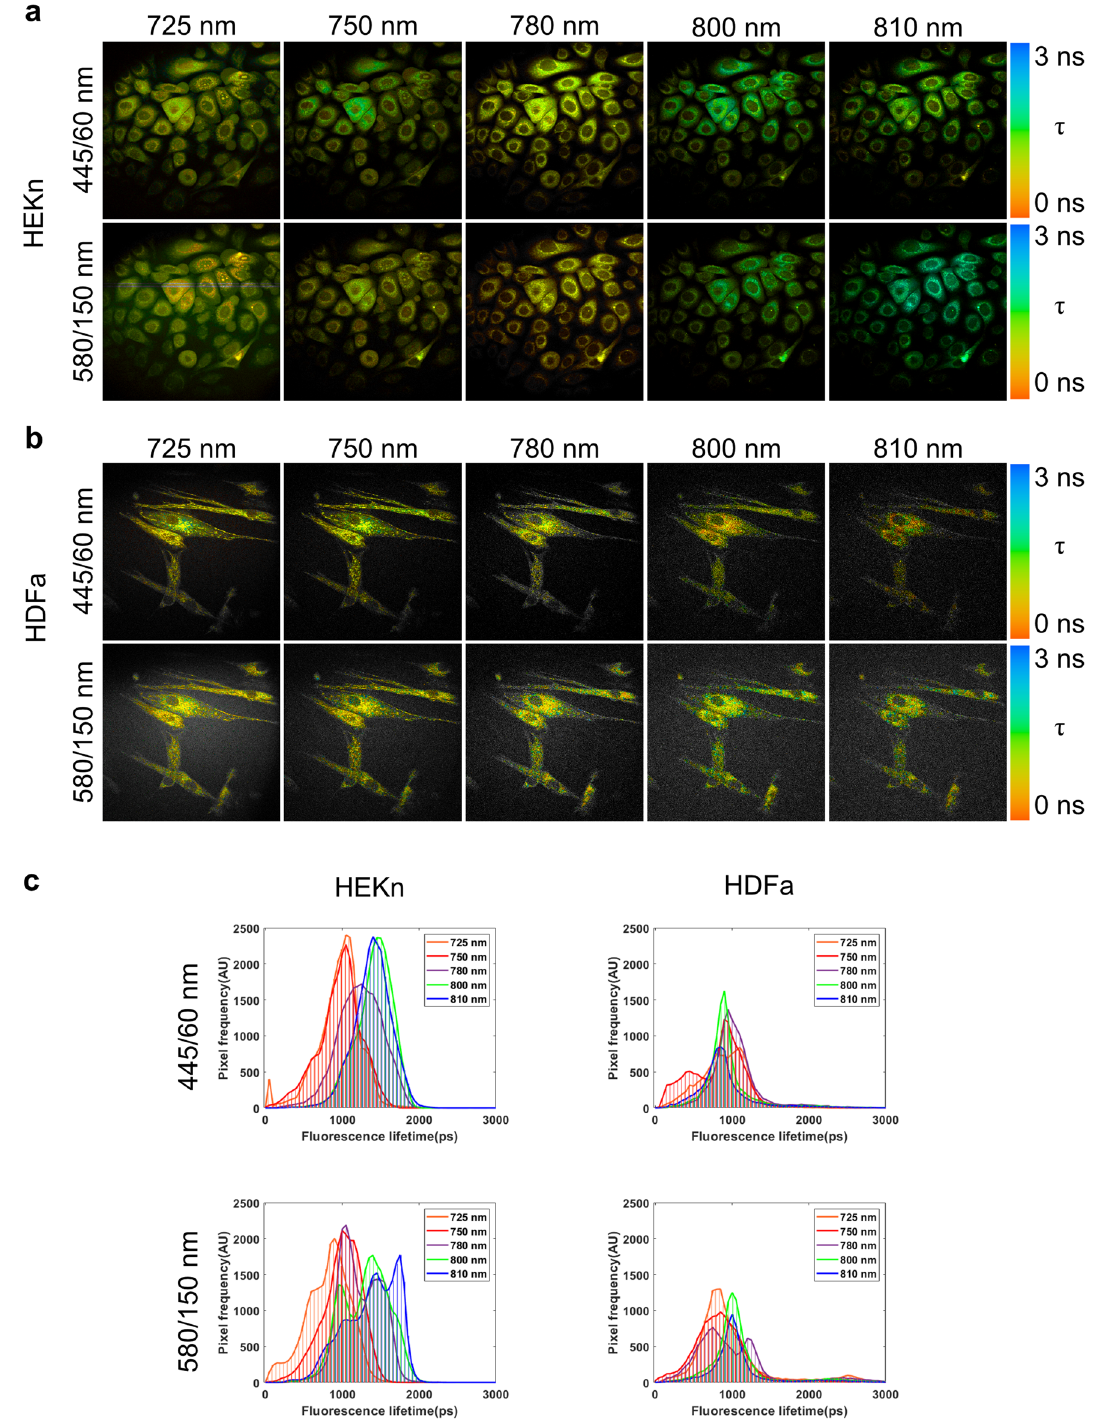
Figure 4. MPM-FLIM analysis reveals a longer fluorescence lifetime component of 1.5 ns present in human keratinocytes, but not in human fibroblasts. MPM-FLIM images of ( a ) human keratinocytes and ( b ) human fibroblasts collected in the blue (445/60 nm) and red (580/150 nm) channel, ( c ) and the corresponding lifetime distribution histograms recorded in the excitation range of 725 to 810 nm. Field of view: ~ 350 × 350 µm 2 . False-color scale fluorescence lifetime data, 256-time channels, ranging from 0 to 3 ns. Brightness and contrast have been adjusted for clarity. The lifetime distribution histograms represent the average lifetime distribution acquired from the whole image frame from three biological